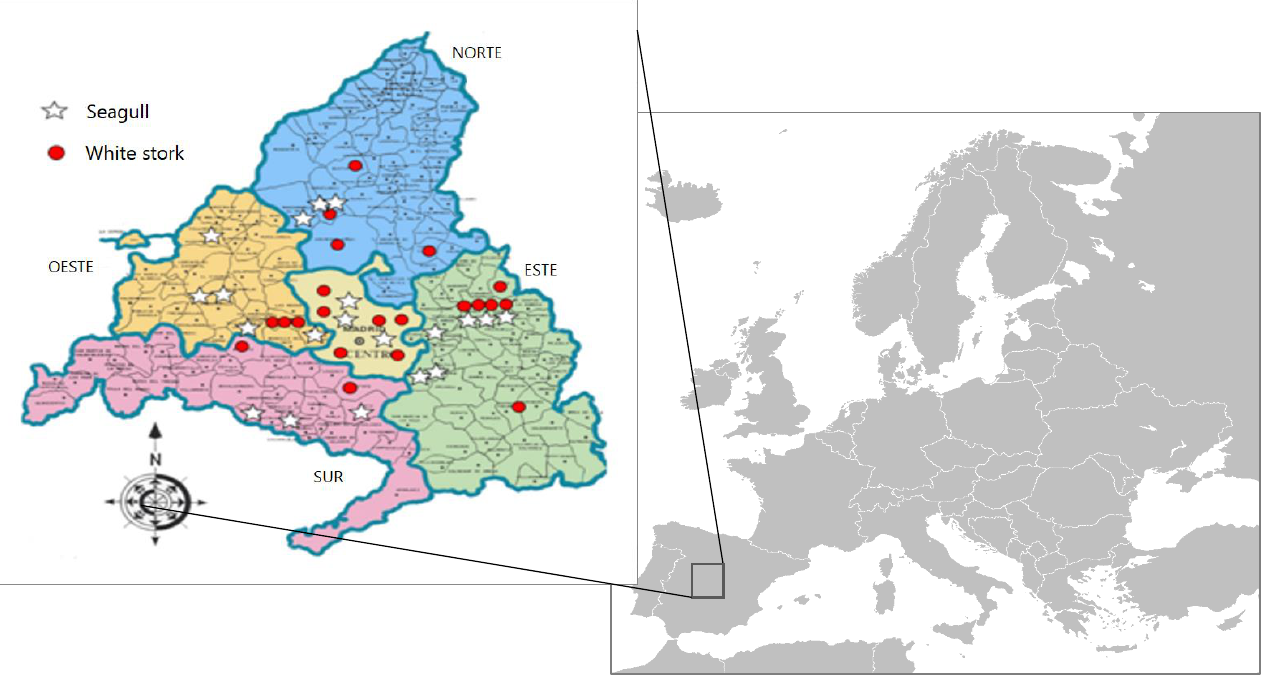
Figure 1. Origin of the animals included in the